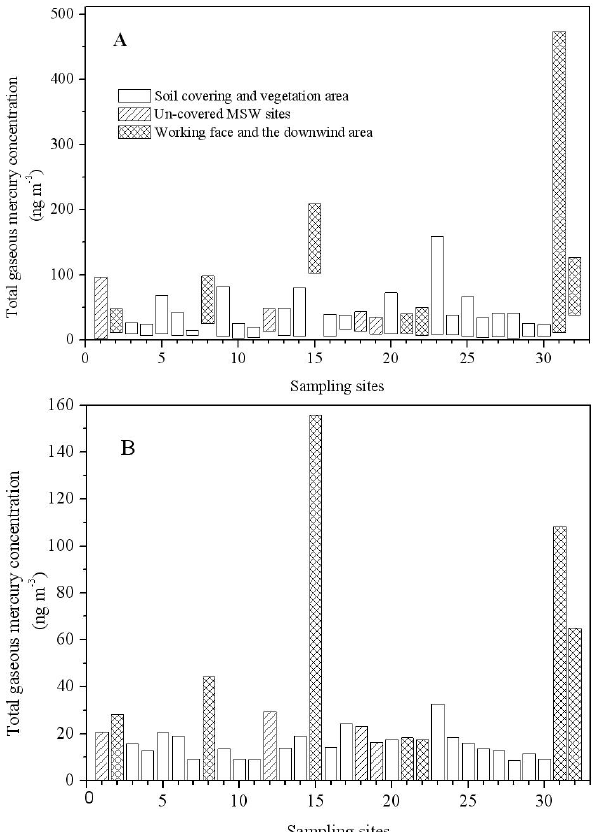
Fig. 3. The range (A) and average (B) of total gaseous mercury in the atmosphere over different sites of the studied landfills (Sample sites: 1–22 at G-Y landfill; 23–27 at D-Z-W landfill; 28 at X-R-J landfill; 29–31 at J-K landfill and 32 at D-S